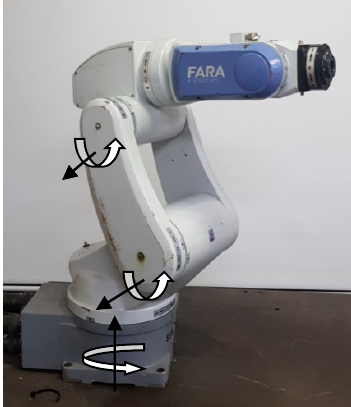
Figure 7. 3-DOF FARA-AT2 robot manipulator.